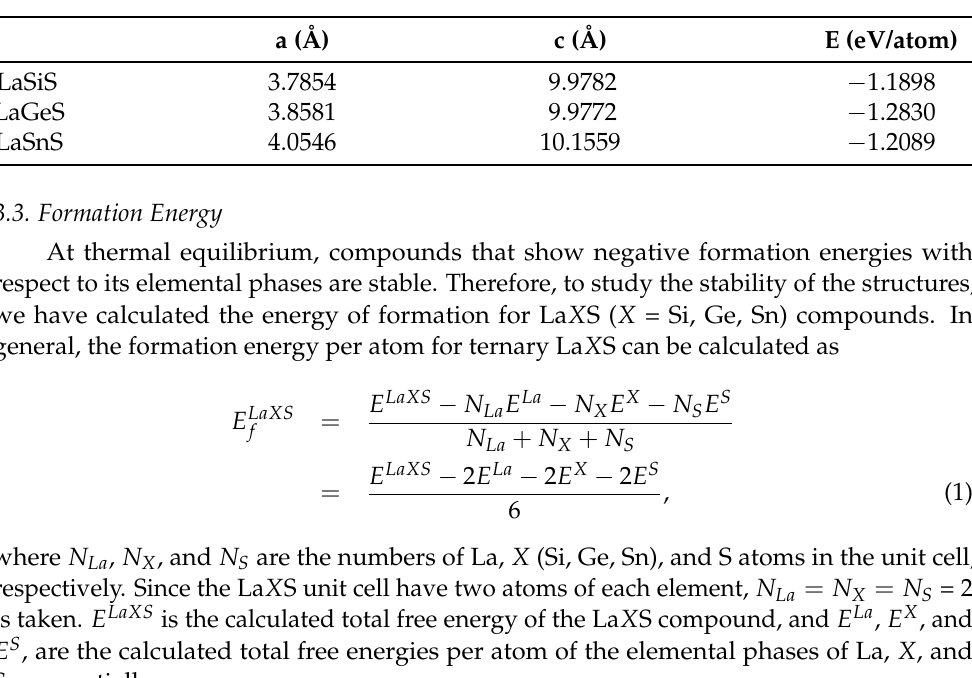
Table 1. The calculated lattice constants a, c, and formation energies, E of La X S